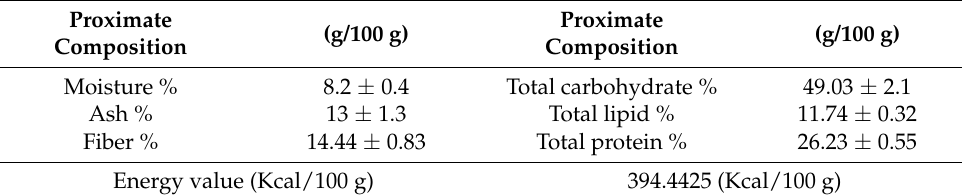
Table 1. Proximate composition (on a dry matter basis) of Colvillea racemosa leaves. Proximate